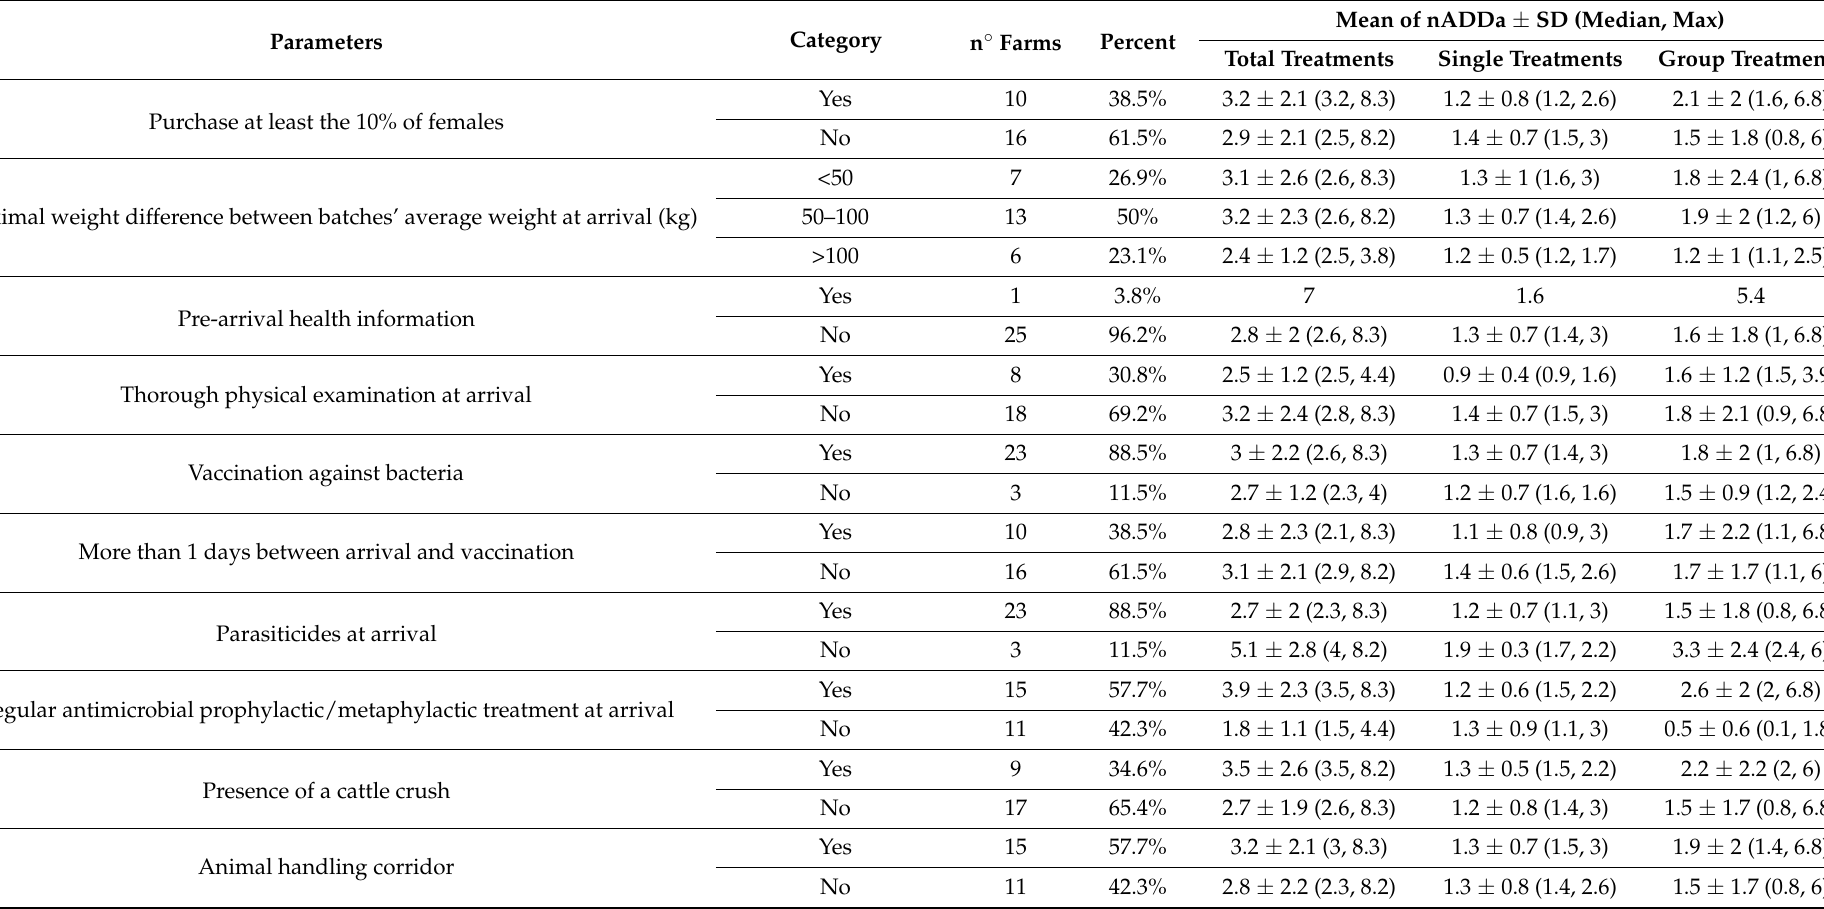
Table 2. Total, individual and group treatment number of animal daily doses per animal (nADDa) are reported as mean ± standard deviation (sd) (median, max) for each parameter of the categorical variables analyzed in 26 fattening operations located in northwestern Italy. Most characteristics are reported as present (“Yes”) or absent (“No”); except for “Maximal weight difference between average batch weight at arrival (kg)”, “Bedding removal in fattening area” and “Bedding removal in fattening area”, which were divided in 3